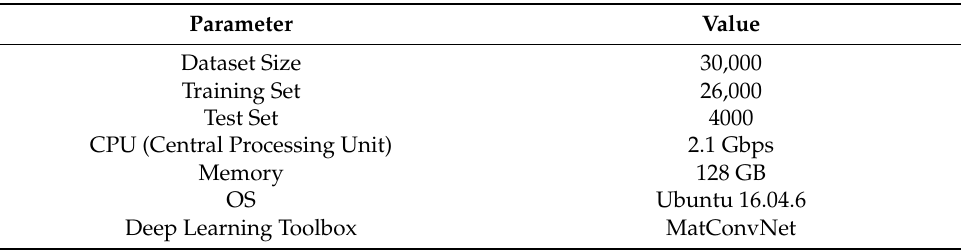
Table 1. Simulation environment.